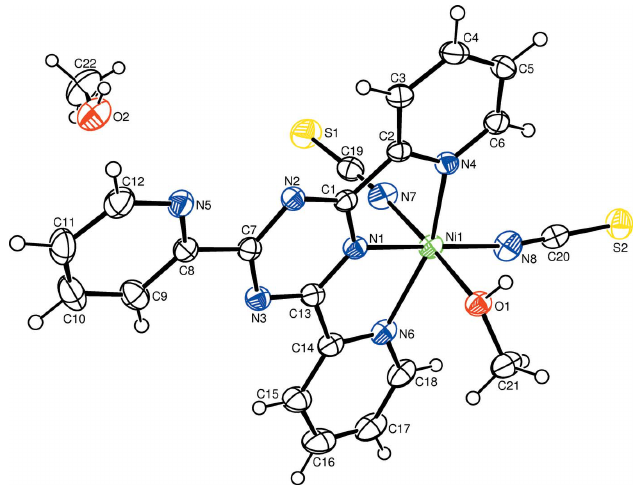
Figure 1 The molecular entities in the crystal structure of the title compound, showing the atom labelling and displacement ellipsoids drawn at the 50% probability level for non-H atoms.